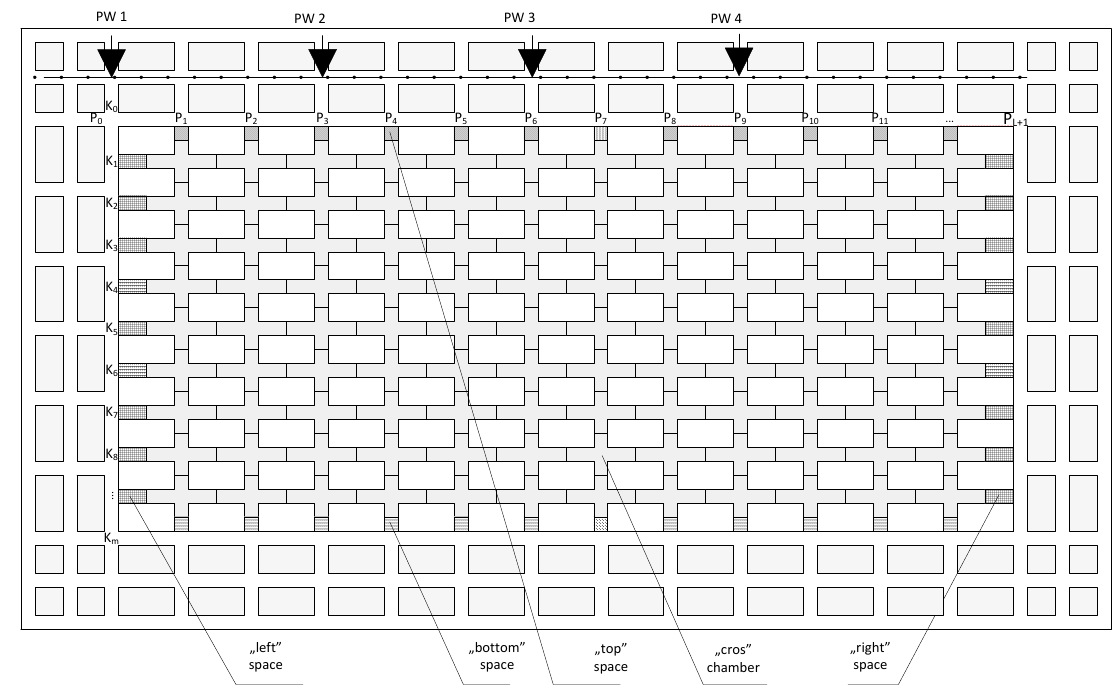
Figure 4. The method of dividing the field of exploitation into the “cross” chambers and additional “bottom” and “top”, “left” and “right” space [24].